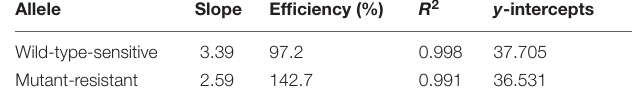
TABLE 4 | Slope, efficiencies, correlation coefficients ( R 2 ), and y -intercepts from amplification of serial dilutions of DNA from Didymella rabiei isolates sensitive and resistant to quinone outside inhibitor fungicides using TaqMan single-nucleotide polymorphism assay to detect G143A mutation. Allele Slope R 2